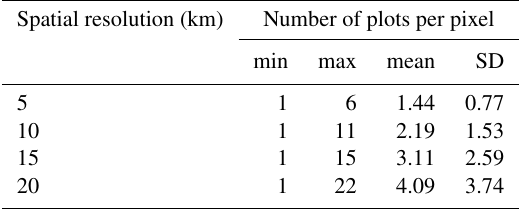
Table 2. Descriptive statistics of the number of plots per pixel for different spatial resolutions (km, pixel length): min is minimum, max is maximum, mean is average, and SD is standard deviation. Spatial resolution (km) Number of plots per